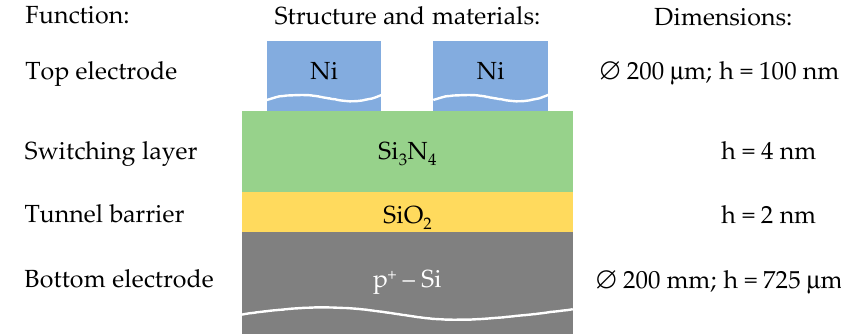
Figure 2. Photo of the manufactured samples and their sketches.